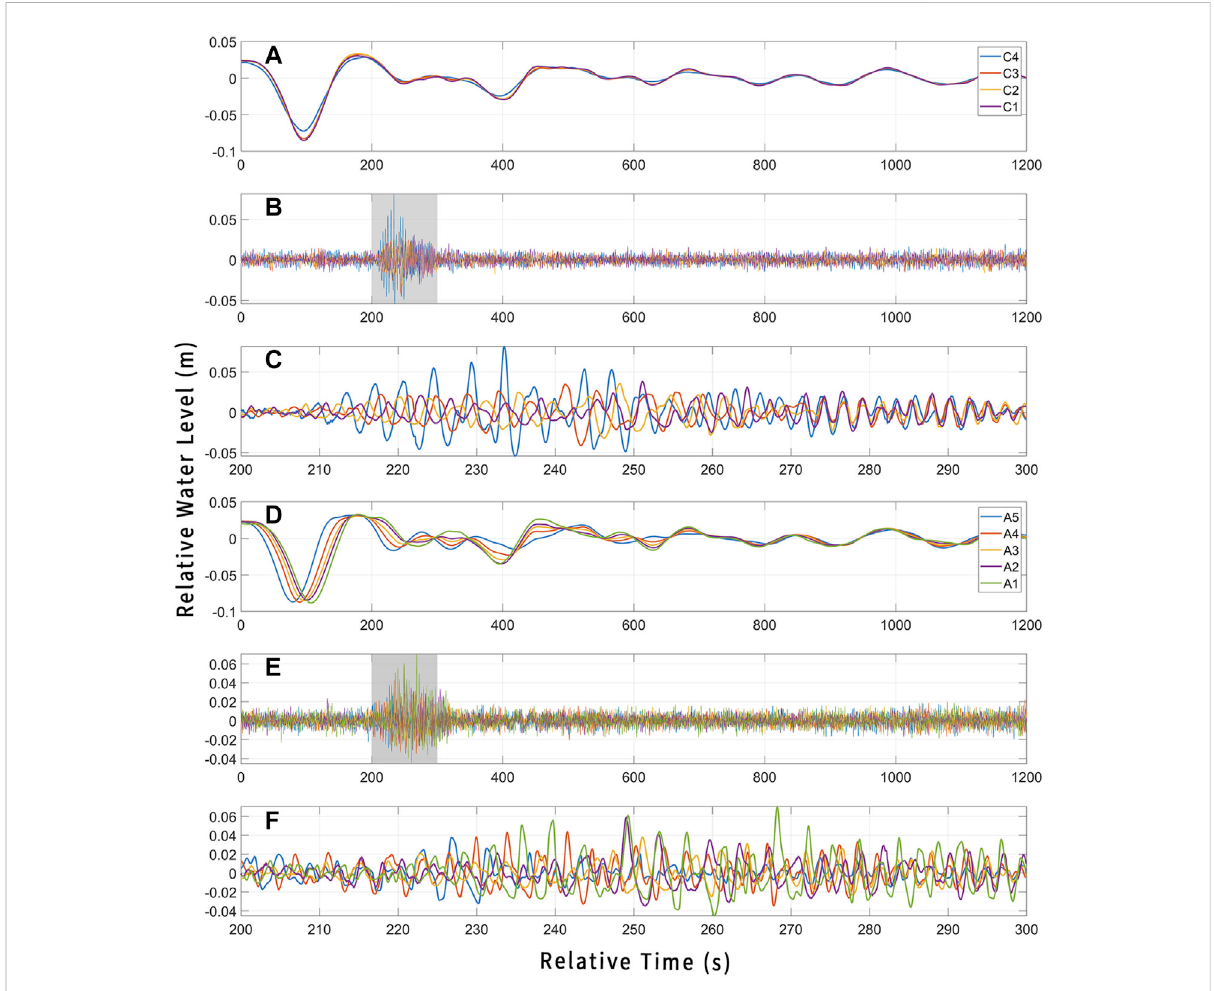
FIGURE 10 Propagation of a sample northbound wake event through the installation, where (A – C) show the cross-shore sensor array and (D – F) show the alongshore sensor array. (A) and (D) are the low frequency signal; (B) and (E) are the high-frequency signal; and (C) and (F) are the high-frequency signal contained in the shaded area in (B) and (E) ,